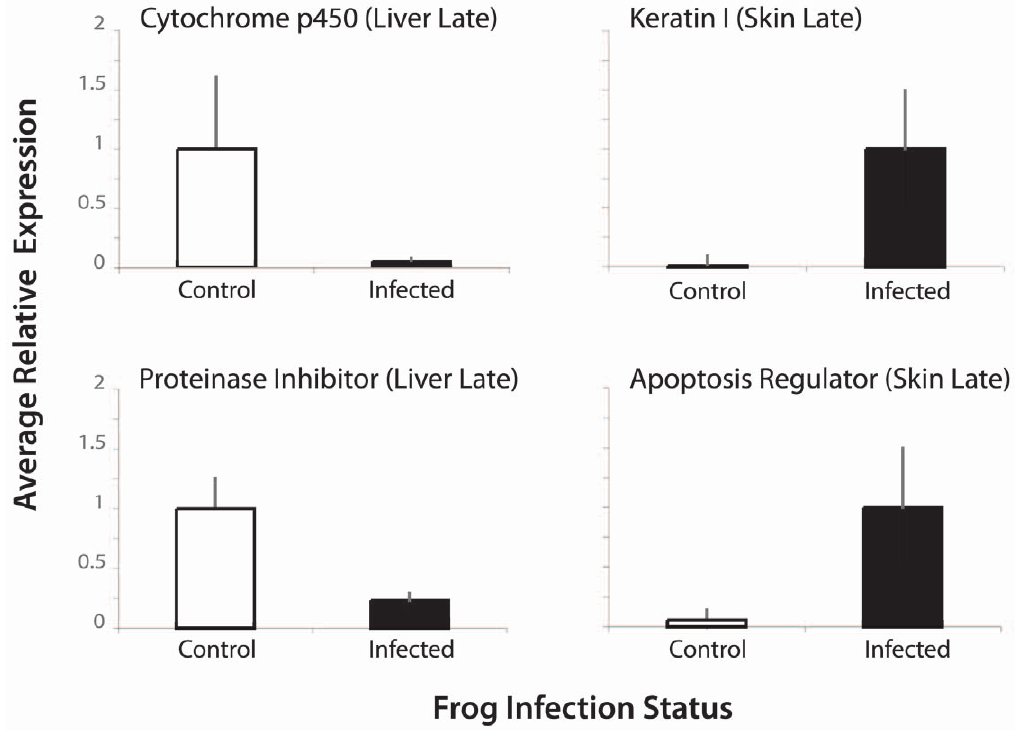
Figure 2. Validation of chip-based gene expression patterns with RT-PCR. Average expression is shown for several genes of interest relative to an endogenous control (beta actin). Mean and standard deviation are shown for biological replicates. In all cases RT-PCR results were in the same direction as array-based results and of comparable (or greater) magnitude.